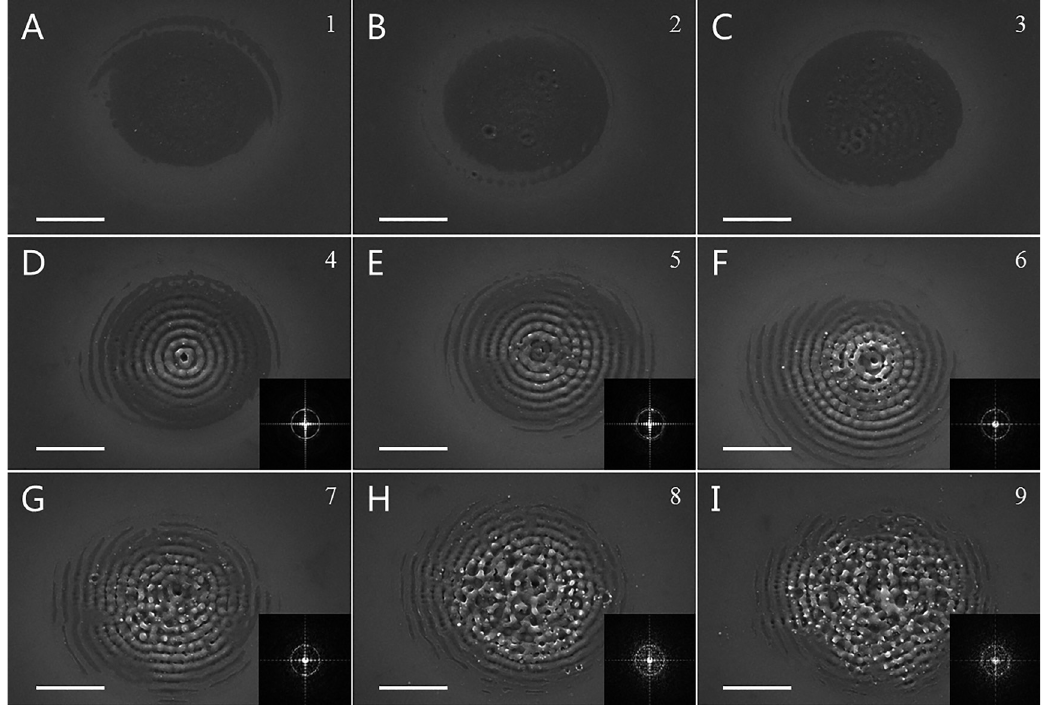
Figure 5: Formation of nanometric concentric ring structures on silicon surfaces with a burst number of 1 – 9 when the time delay between two subpulses was fixed at 1200 fs. Scale bar: 5 μ